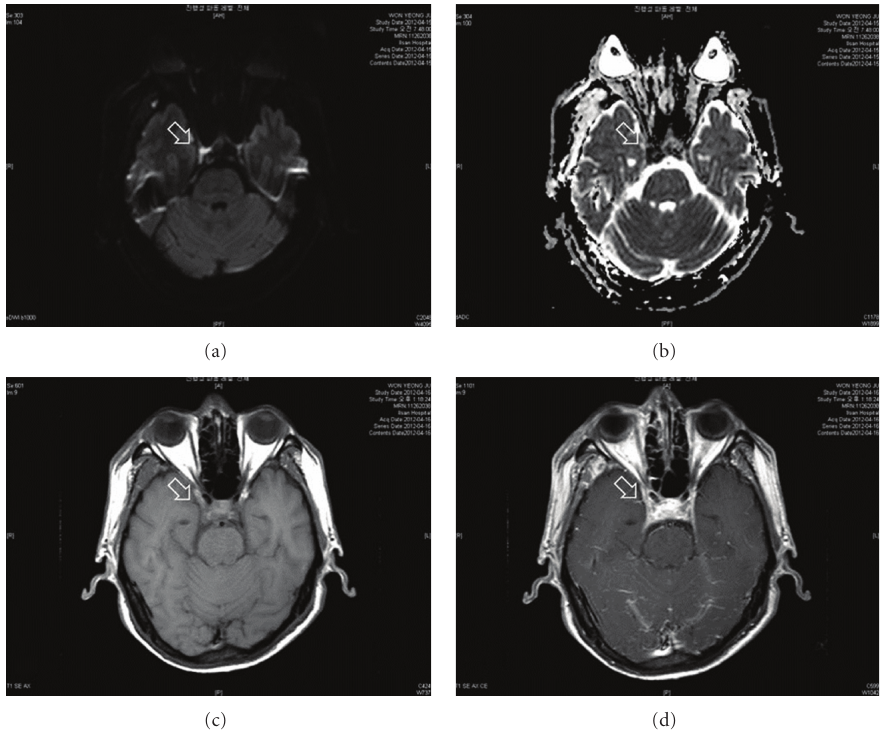
Figure 2: MR images reveal the presence of an abscess in the cavernous sinus area (white arrow, (a)–(d)). Di ff usion restriction around the right cavernous sinus indicates an abscess in the di ff usion-weighted MR image (a). There is no high signal around the right cavernous sinus in the apparent di ff usion coe ffi cient map (b). Precontrast T1-weighted MR image (c). More enhancement around the right cavernous sinus area was observed in the postcontrast T1-weighted MR image